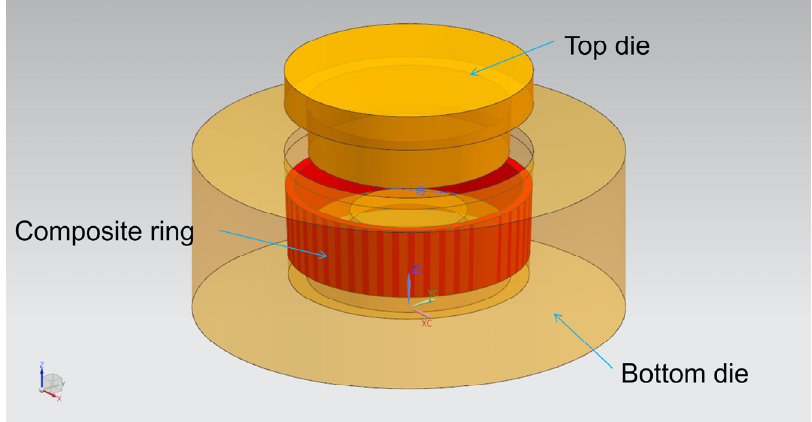
Figure 2. Dies assembly model for compound casting drawn by UG software.